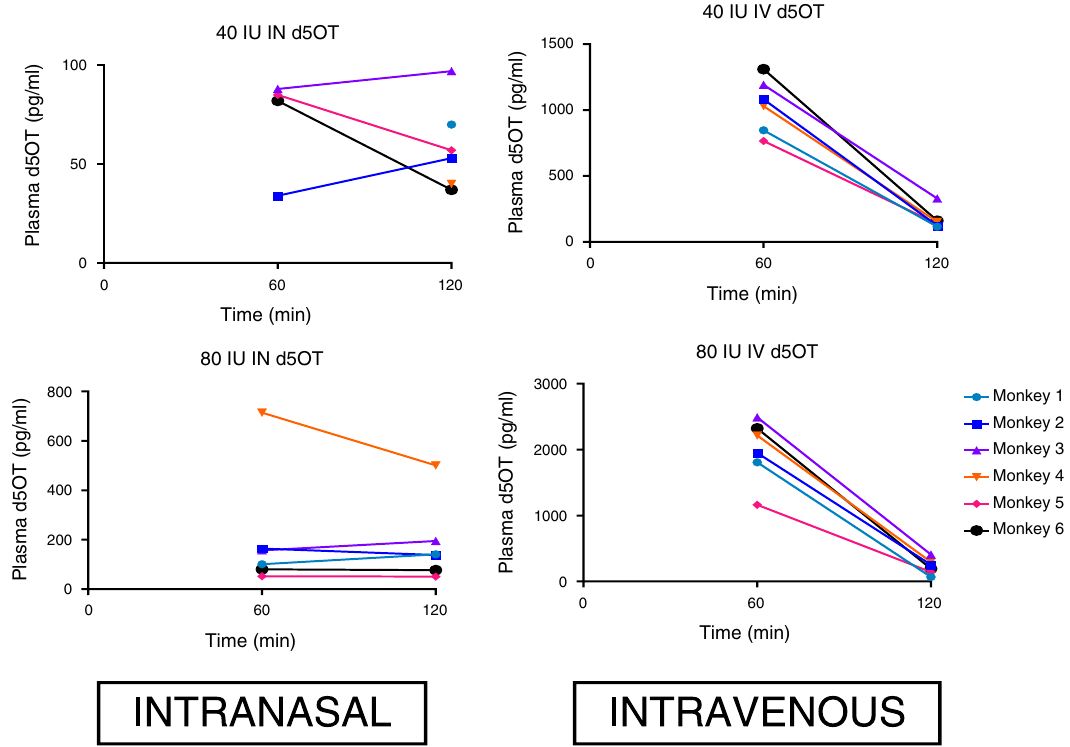
Fig. 2 Plasma d5 oxytocin (OT) concentrations: time course of d5OT concentrations in monkey plasma after intravenous (IV) and intranasal (IN) administration of 80 and 40 IU d5OT ( N = 6). Limit of quanti fi cation = 100